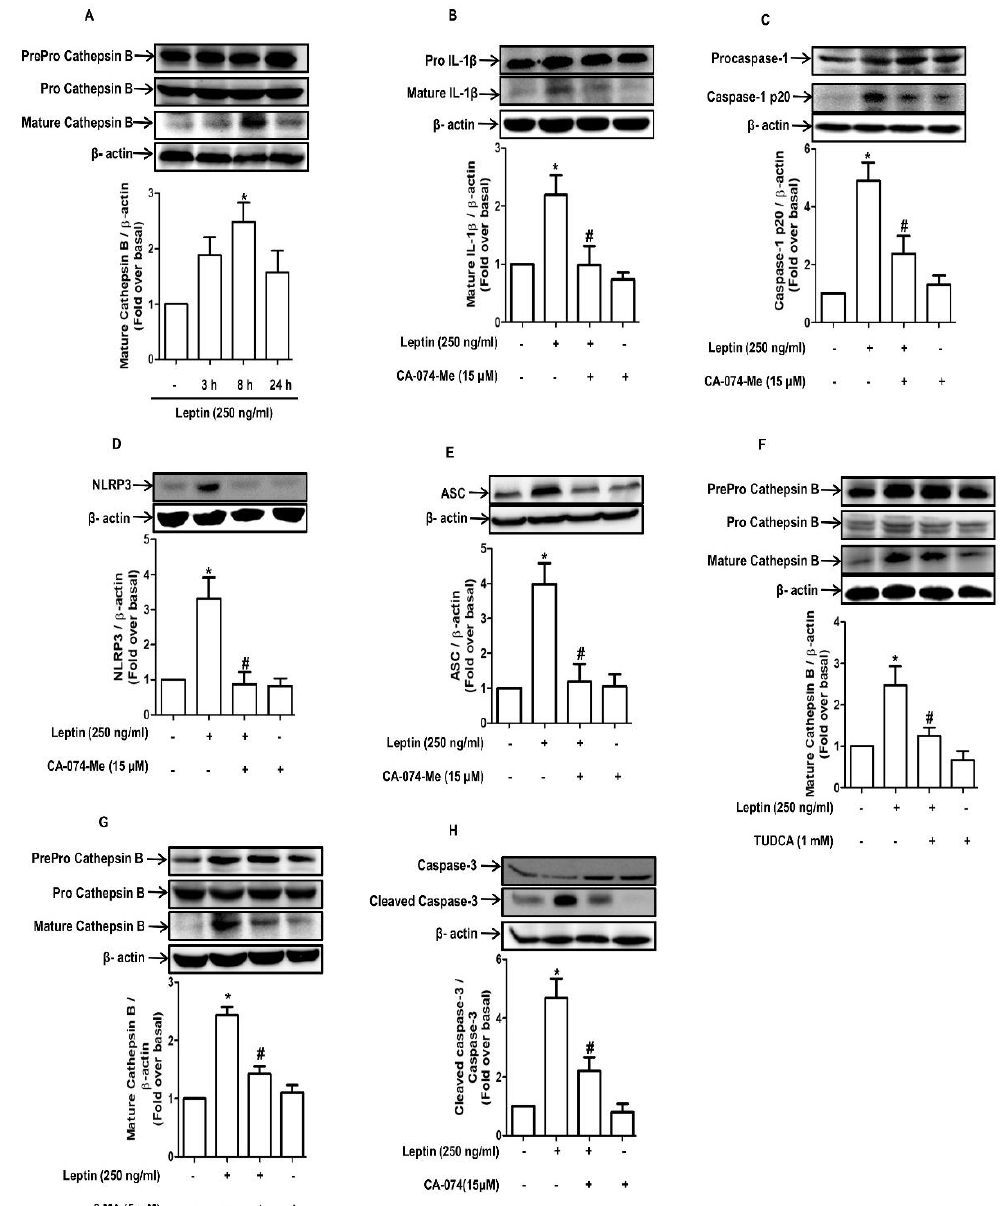
Figure 6. Effect of leptin on cathepsin B maturation and its involvement in inflammasome activation in rat hepatocytes: ( A ) Hepatocytes were treated with leptin for the indicated time durations. Expression of prepro-, pro, and mature cathepsin B were measured by Western blot analysis. ( B – E ) Cells were pretreated with CA-074-Me for 1 h followed by further incubation with leptin for 8 h. Expression levels of the genes related to inflammasomes, including pro- and mature IL-1 β ( B ), pro- and active caspase-1 ( C ), NLRP3 ( D ), and ASC ( E ) were determined by Western blot analysis. ( F , G ) Rat hepatocytes were pretreated with TUDCA ( F ) or 3-MA ( G ) for 1 h and were further incubated with leptin for 8 h. Expression levels of prepro-, pro-, and mature cathepsin B were determined by Western blot analysis. ( H ) Cells were pretreated with CA-074-Me for 1 h followed by further stimulation with leptin (250 ng/mL) for 8 h. Cleaved active caspase-3 formation was assessed by Western blot analysis. For all the Western blot analyses, protein expression of the target genes was quantitated by densitometric analysis and is shown in the lower panel of each image. Values are presented with fold changes compared to the control and are expressed as mean ± SEM, n = 3. * represents p < 0.05 compared to control cells; # represents p < 0.05 compared to the cells treated with leptin alone.